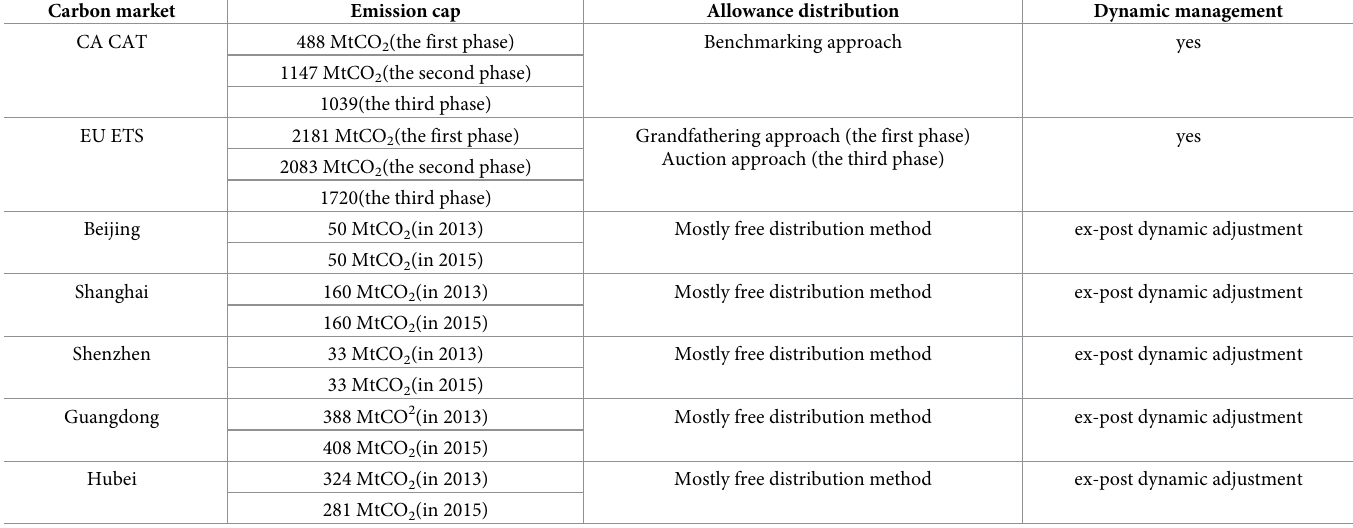
Table 1. Comparison of China’s ETS, EU ETS and CA